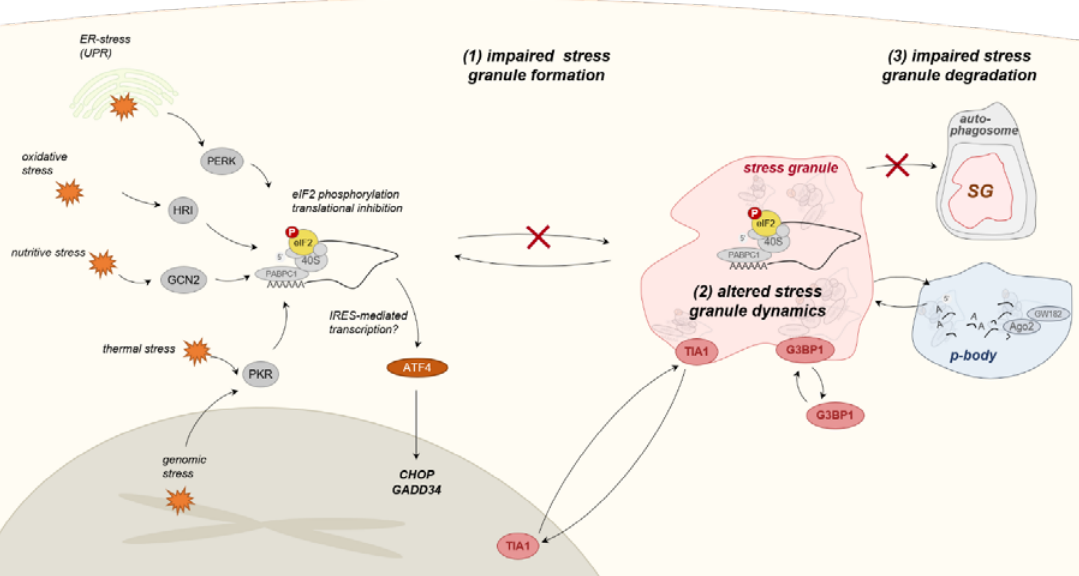
Figure 4. Schematic representation of the integrates stress response (ISR) in the context of muscular disorders. Stressor-specific response pathways converge into a unified pathway by means of ISR. Central mechanism of the ISR is the phosphorylation of eukaryotic translation initiation factor 2α (eIF2α), leading to the translational inhibition of the preinitiation complex. The non-translating complexes are incorporated into stress granules together with other RNA-binding proteins (e.g., TIA1 and G3BP1). In muscle diseases, both an impaired stress granule formation, as well as altered stress granule dynamics, have been identified as pathogenic mechanisms. Furthermore, a defective stress granule degradation via autophagic pathways has been considered to contribute to disease progression.